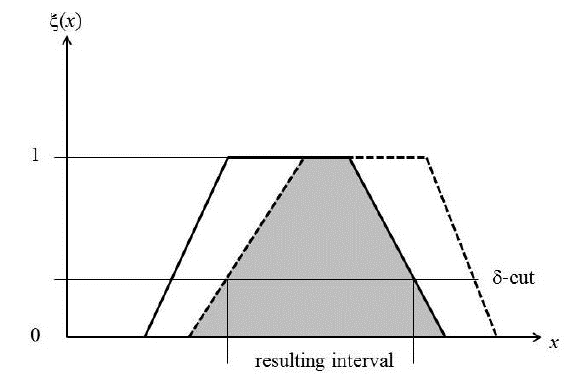
Figure 2. Combination of two fuzzy numbers